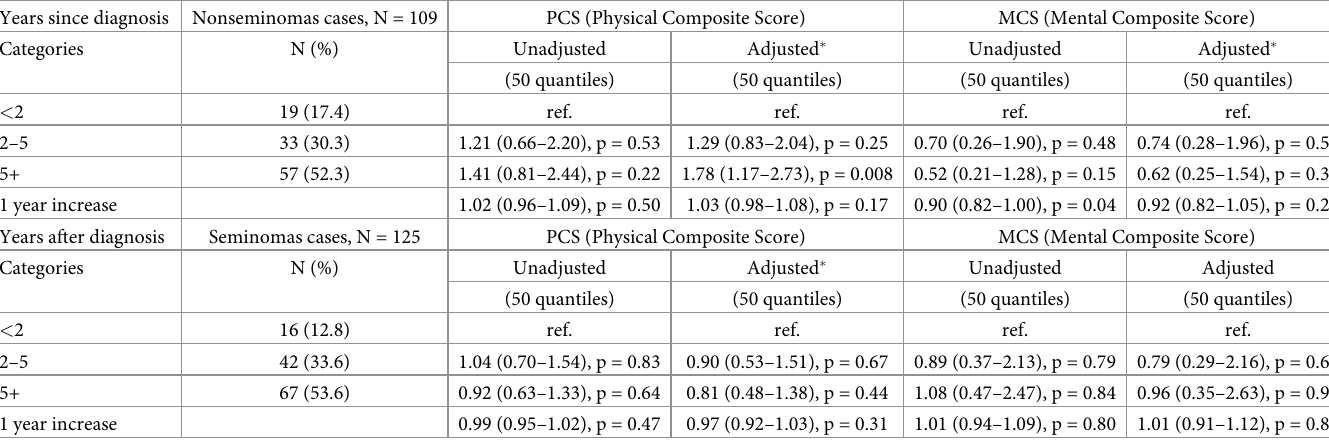
Table 4. ORs (odds ratios) and 95% confidence intervals (95% CI), estimated using logistic quantile regression of median of PCS and MCS for time since cancer diagnosis of nonseminoma and seminoma cases. Years since diagnosis Nonseminomas cases, N =